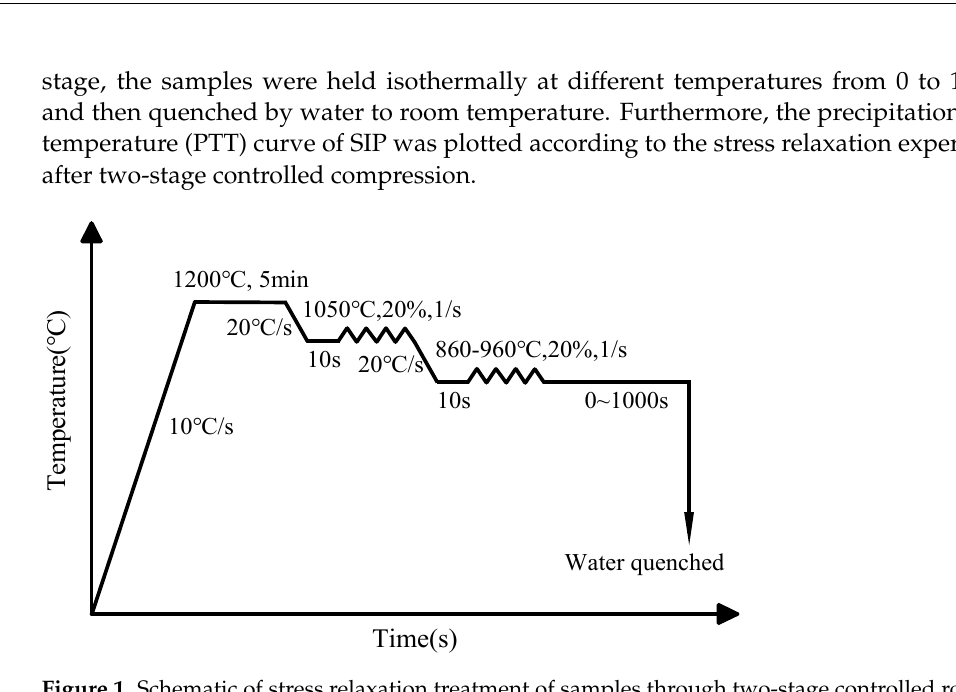
Figure 1. Schematic of stress relaxation treatment of samples through two-stage controlled rolling.